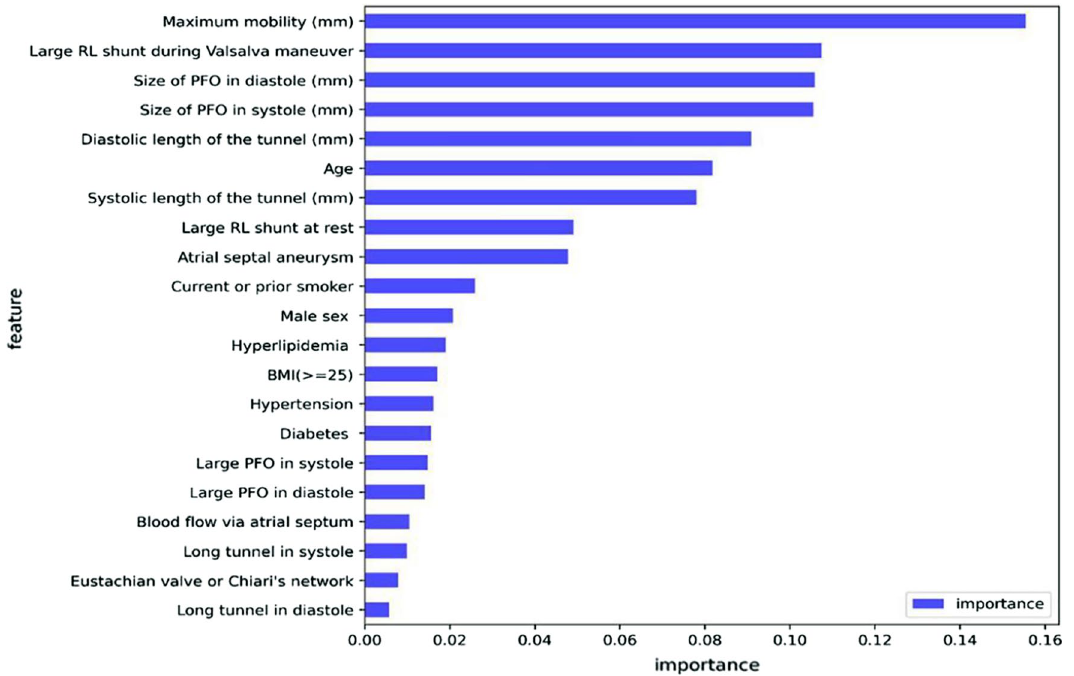
Fig. 7 The importance of the random forest model